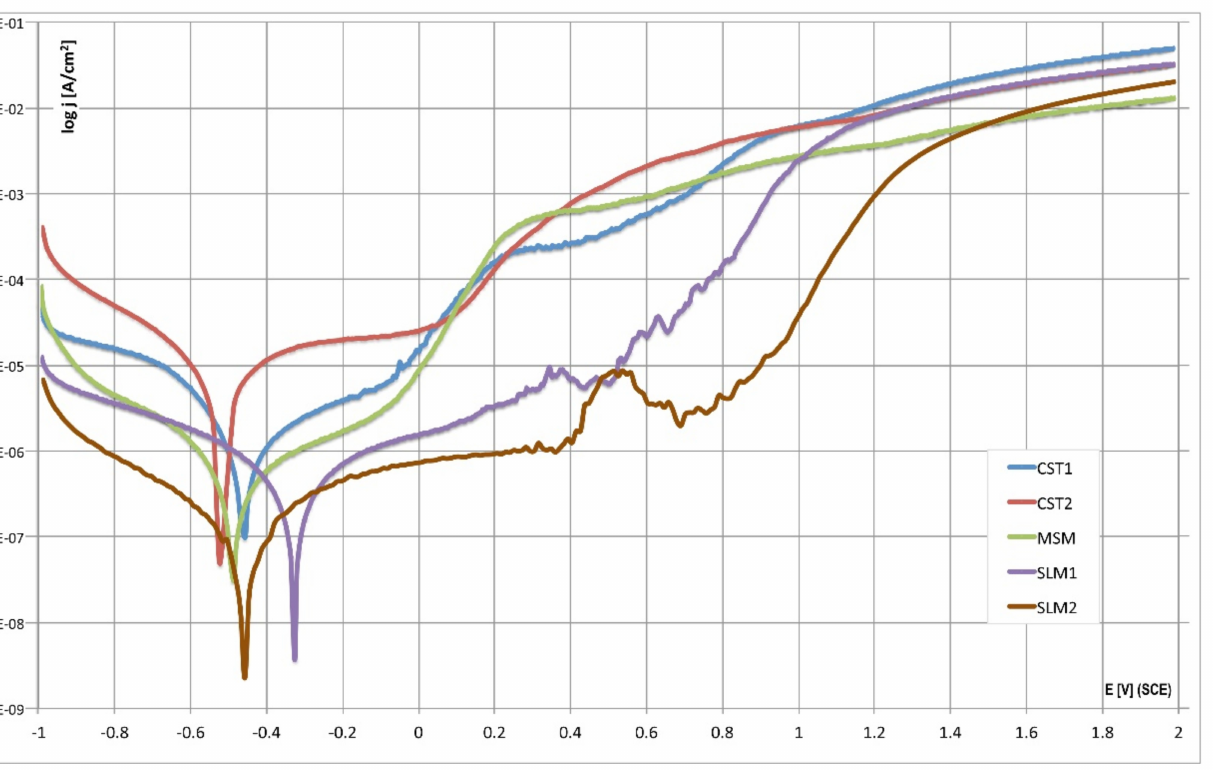
Figure 8. Potentiodynamic curves obtained for examined